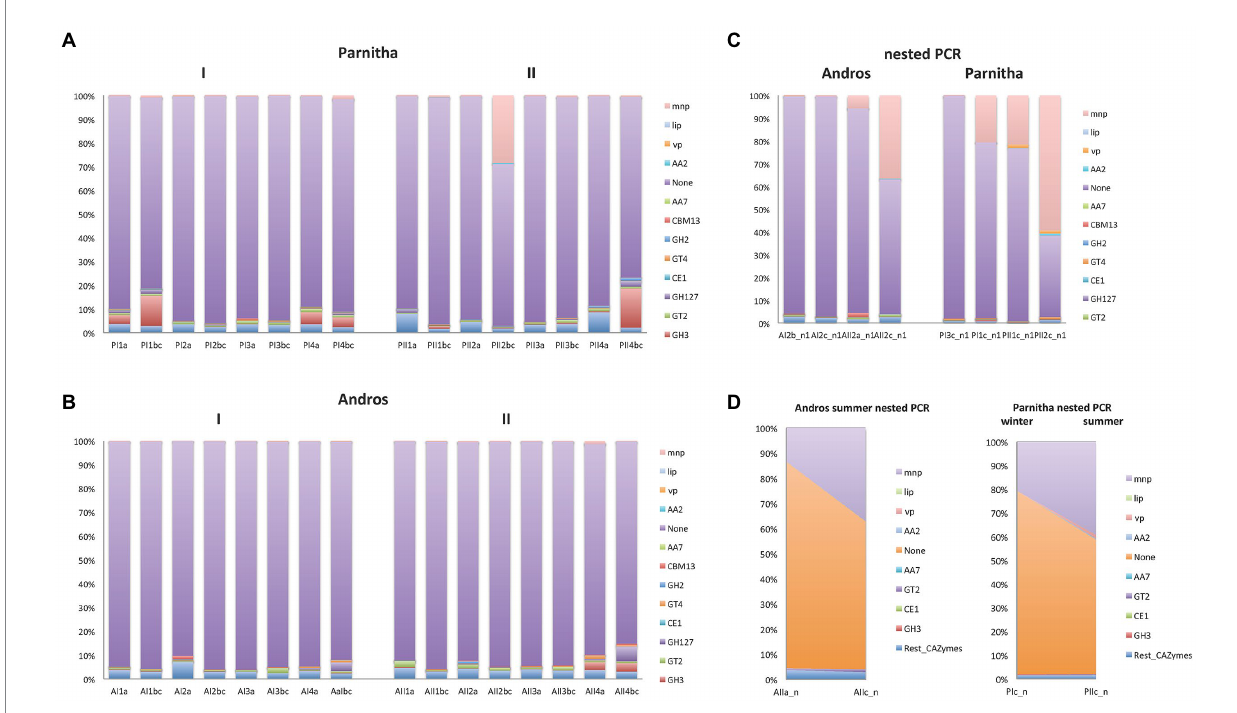
FIGURE 4 The distribution of AA2 peroxidases and the most abundant CAZymes in the sampling plots (1,2,3,4), soil depths (a,b,c) and seasons (I = winter, II = summer) of (A) Parnitha and (B) Andros forests. The distribution of the same enzyme sequences obtained by nested PCR reactions are also shown for comparison (C) , while the significant increase of AA2 sequences with depth, in both forests, is shown in ( D ; examples: at summer, with depth, Andros; winter-summer, deeper samples,